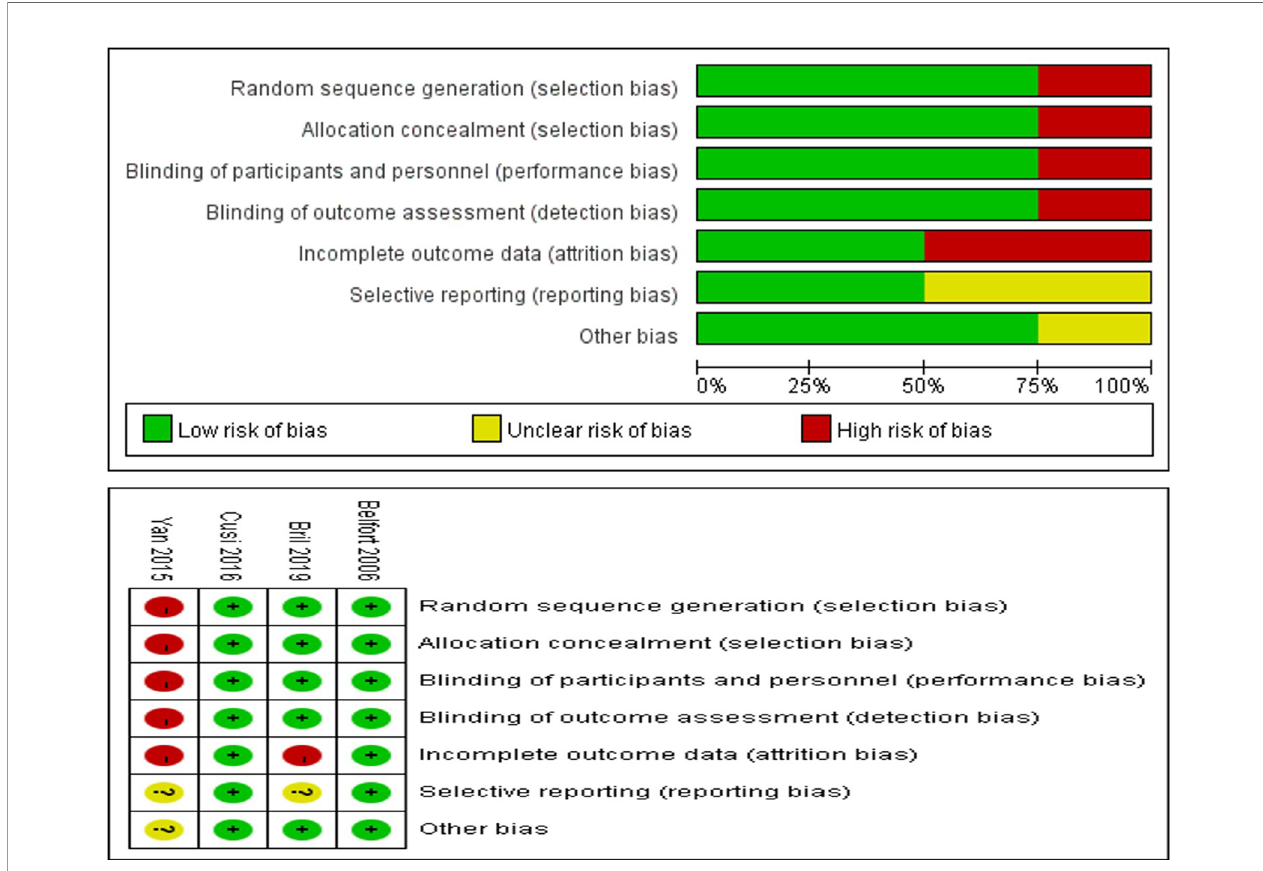
FIGURE 2 | Risk of bias summary for review authors ’ judgments about each risk of bias item for each included